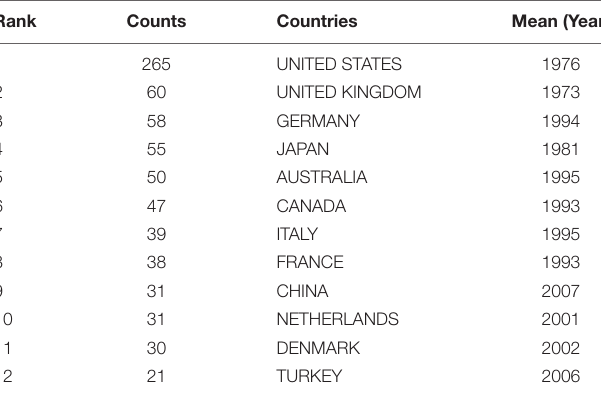
TABLE 1 | Number of articles published in the top 12